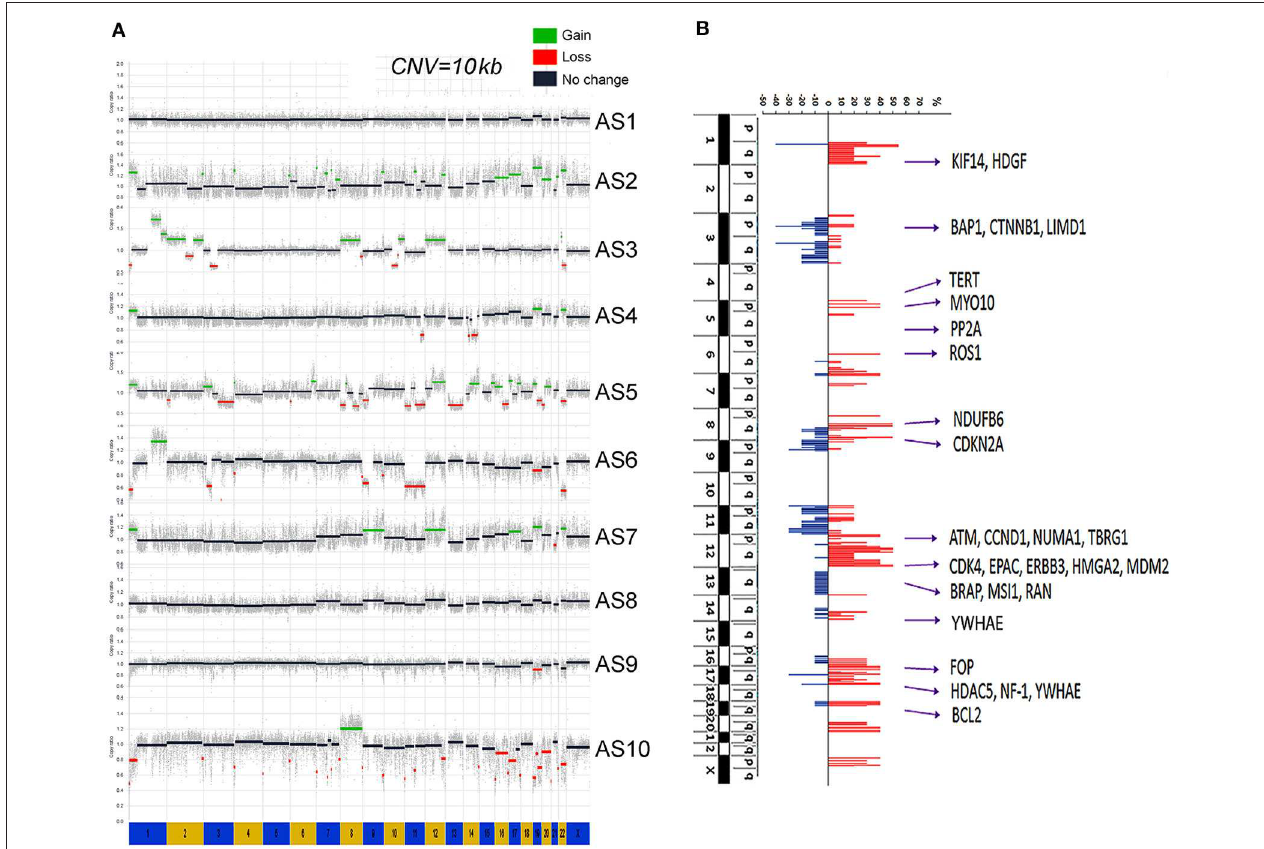
FIGURE 1 | Genome copy number variation (CNV) analysis by whole-genome sequencing (WGS). (A) The genomic landscape of copy number gain (green) and loss (red) in each of 10 Müllerian adenosarcomas (MAS, numbered AS-1 through AS-10). (B) The accumulated CNV in 10 cases. The scale bars of copy number gain (red) and loss (blue) indicated the percentage of study cases (y axis). A total of 28 genes corresponding to genomic amplification were selected for protein expression analysis.